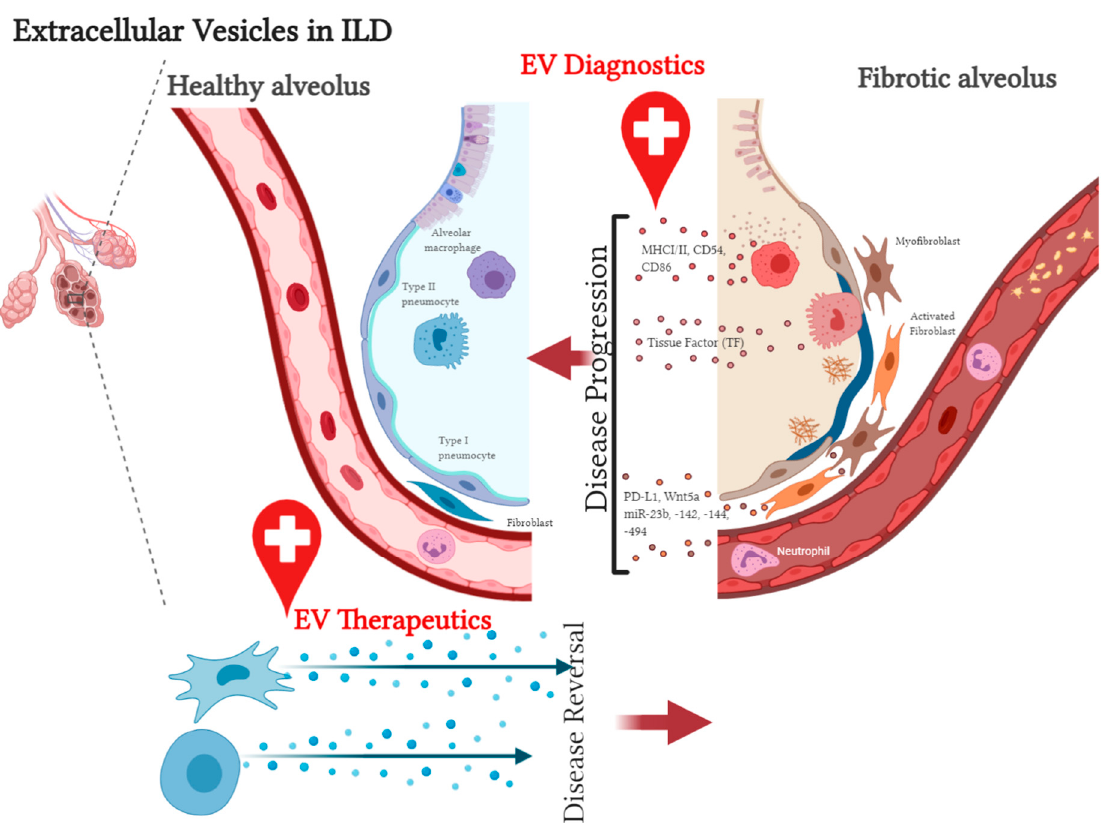
Figure 3. Extracellular vesicles in interstitial lung diseases. The secretion of pathologic EVs from the injured and fibrotic microenvironment, principally inflammatory cells, epithelial cells, activated fibroblasts, and myofibroblasts triggers further damage in local and distant healthy tissue. Identifying the signals carried by these EVs aids in the development of diagnostic tools to diagnose and track disease progression. EVs derived from therapeutic cell types can also be used to reverse disease phenotype through tissue immunomodulation and tissue repair.